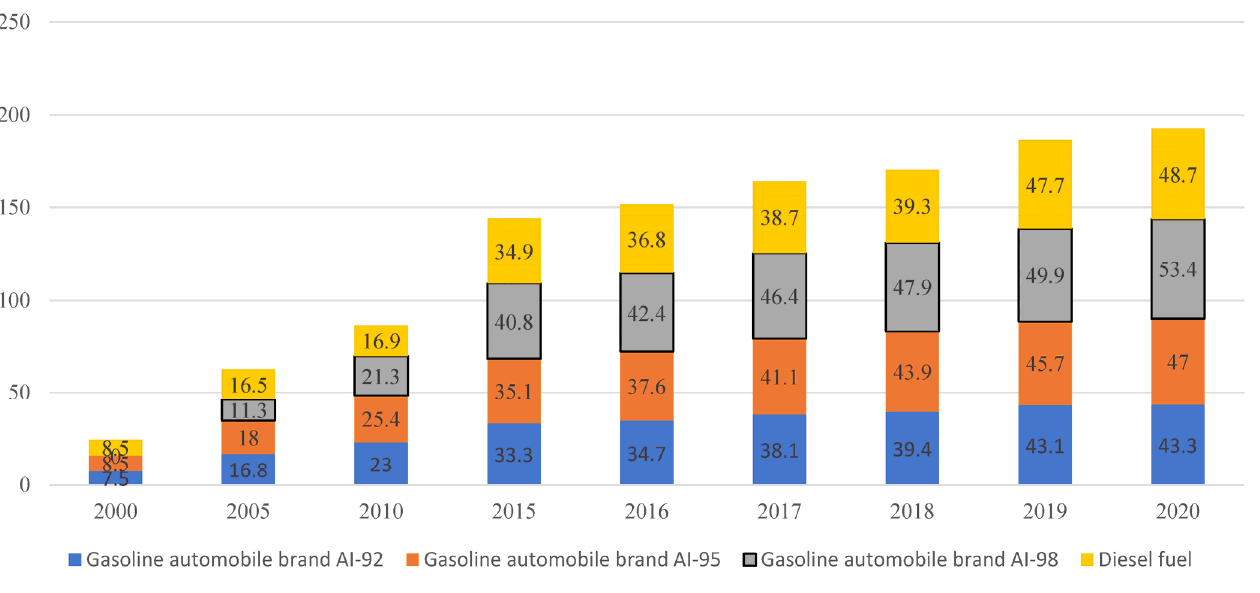
Figure 9. Dynamics of Russian prices for motor gasoline and diesel fuel for the period 2000–2020, rubles/liter. Compiled by the authors according to: